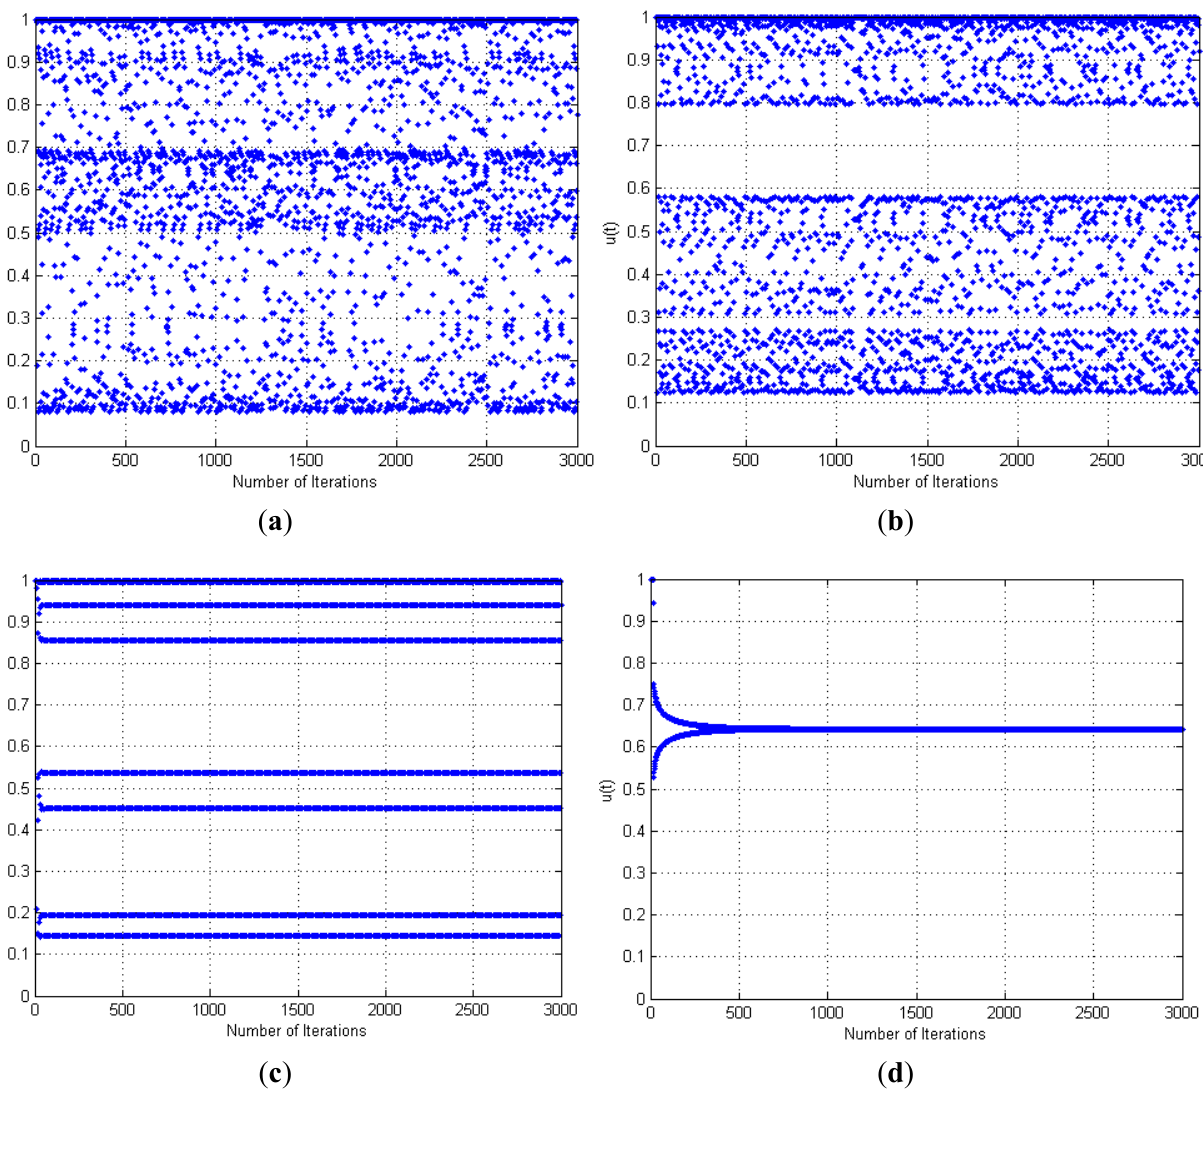
Figure 3. For various T (t) during 3000 iterations, demonstrates the various bifurcation